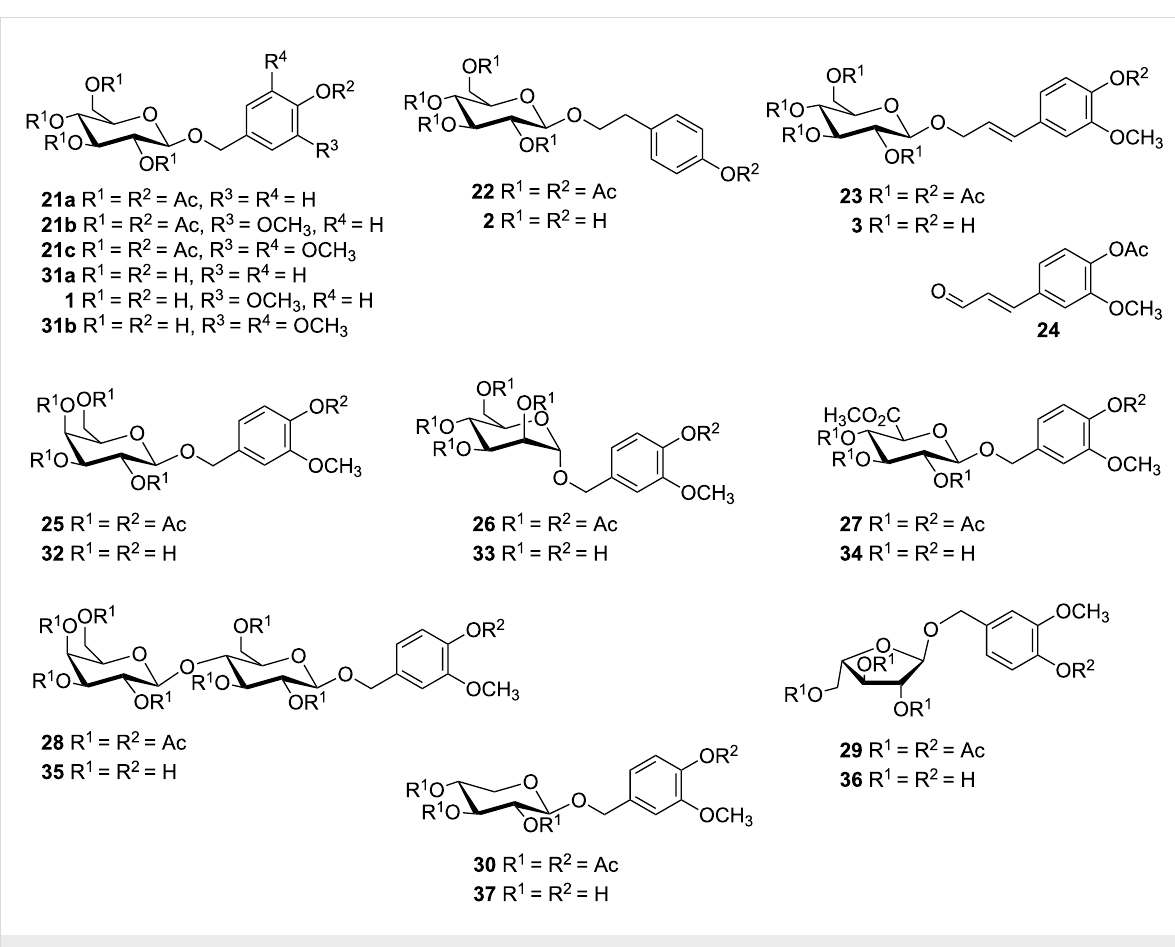
tion. In many cases, the DDQ–I 2 -promoted reaction provided products in a stereoselective way and in the highest yields. It is noteworthy that ZnO–I 2 is a new glycosylation promoter, which was found to well activate also less reactive disarmed tetra- O - acetyl- α -D-glycopyranosyl bromides, to give stereoselectively only the 1,2- trans glycosides in good to high yields. These conditions were efficiently used in the stereoselective xyloside synthesis that is not trivial. All used glycosylation conditions were compatible with acetyl protective groups of the phenolic function. The coupling reaction and deprotection were achieved in two steps, thus providing the rapid access to the targeted